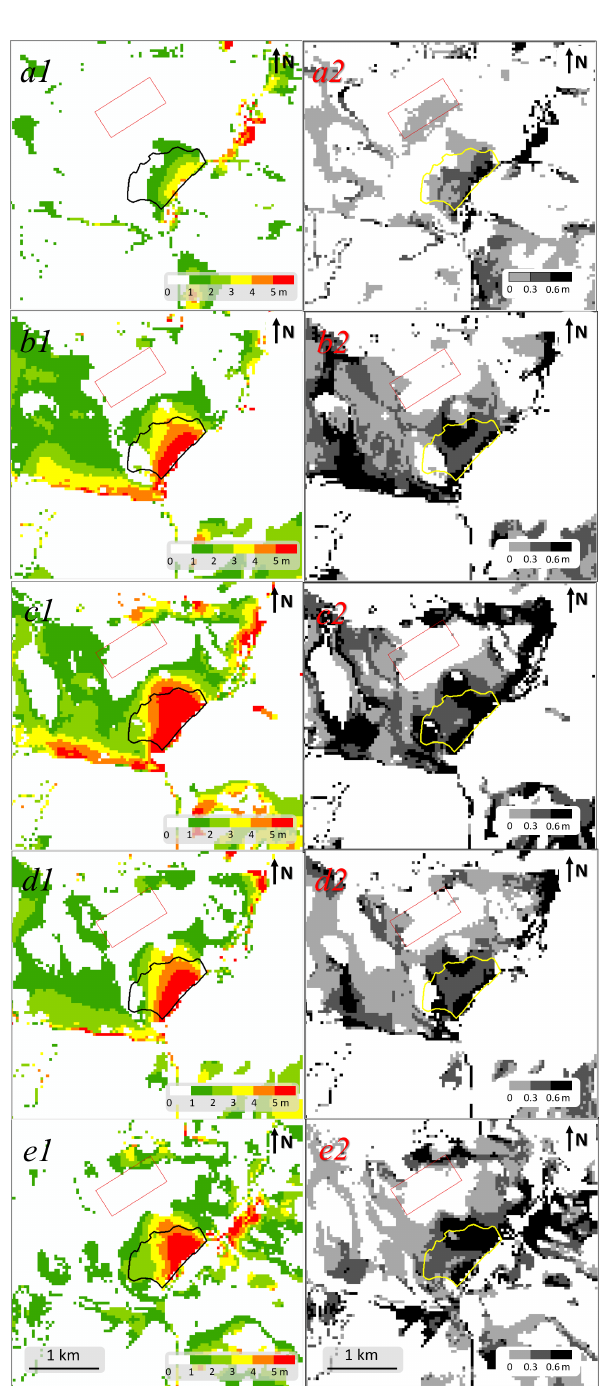
Figure 3. Means and standard deviations of the derived slope dis- placements in the five targeted images (Table 1). Detected means and SDs of slope displacement on 13 April 2019 (a1–a2) , 17 July 2019 (b1–b2) , 24 August 2019 (c1–c2) , 5 October 2019 (d1–d2) and 12 November 2019 (e1–e2)